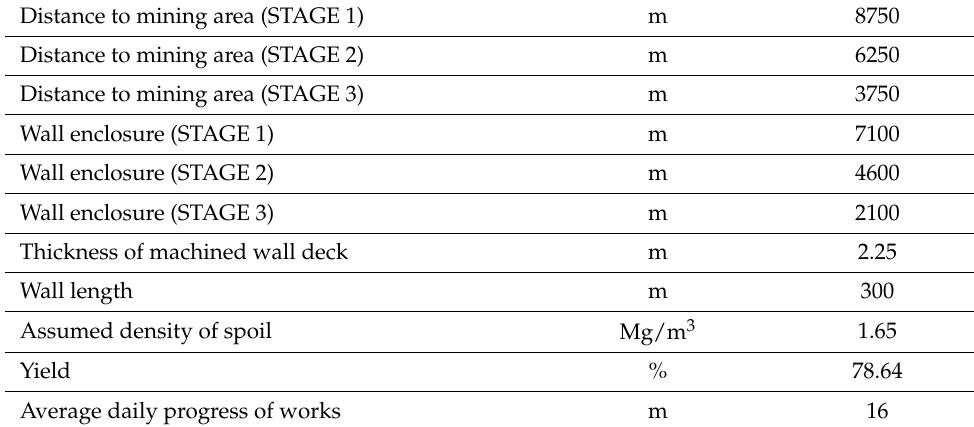
Table 1. Summary of distance from the material to downhill shaft and operational parameters of the mining